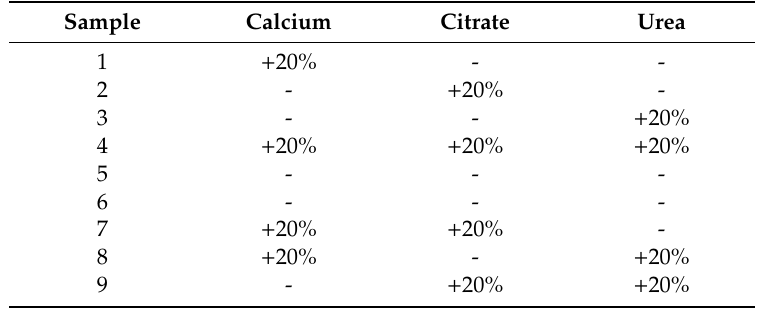
Table 1. Experimental design of the 2 3 full factorial study. Milk with elevated levels of calcium, citrate, and urea were prepared as below and the samples were subject to ultra-high temperature